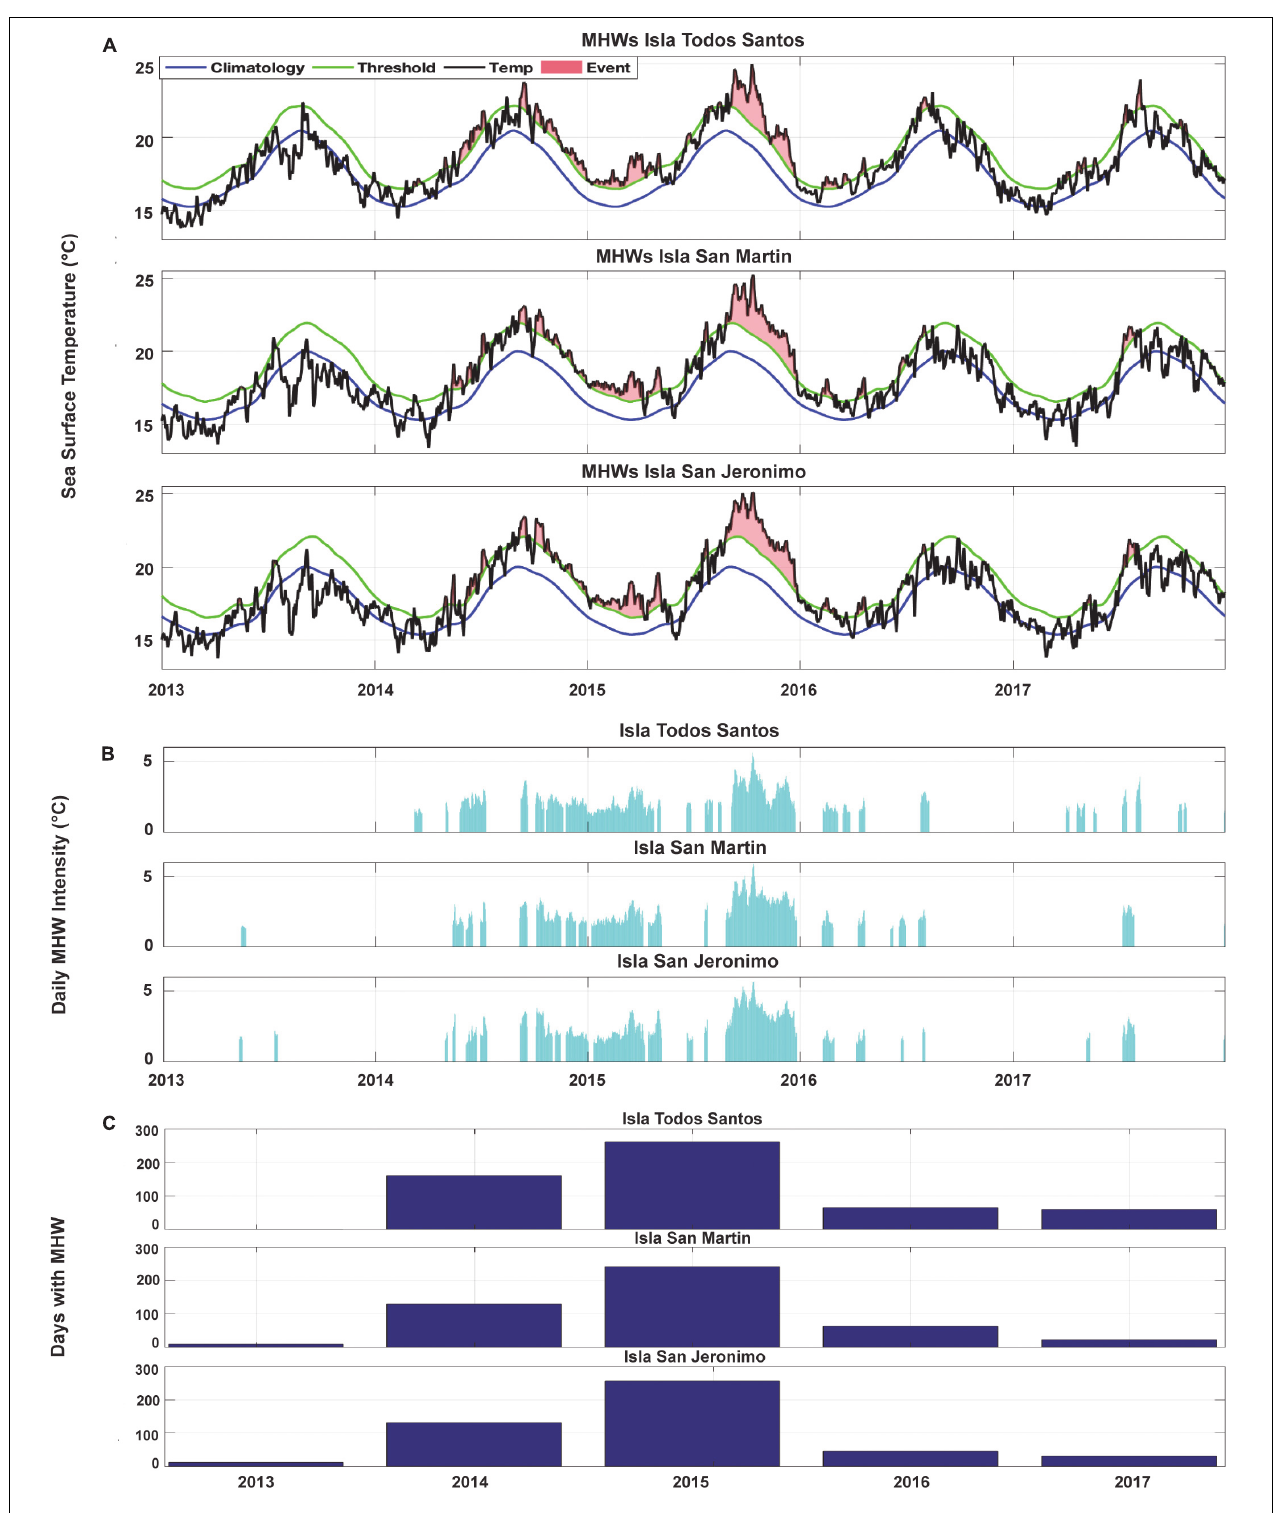
FIGURE 3 | (A) Blue lines indicate the sea surface temperature (SST) climatology, green lines represent the 90th percentile that defines a marine heatwave (MHW), black lines are the SST time series, and the orange shaded region indicates all MHWs identified. (B) The daily MHW intensity, (C) the number of MHW days registered during 2013–2017 for Isla Todos Santos, Isla San Martin, and Isla San Jeronimo.